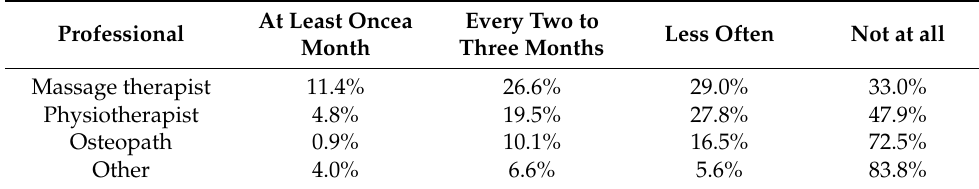
Table 6. Distribution of treatment frequency of 745 dogs by a massage therapist, physiotherapist, osteopath or other professionals during